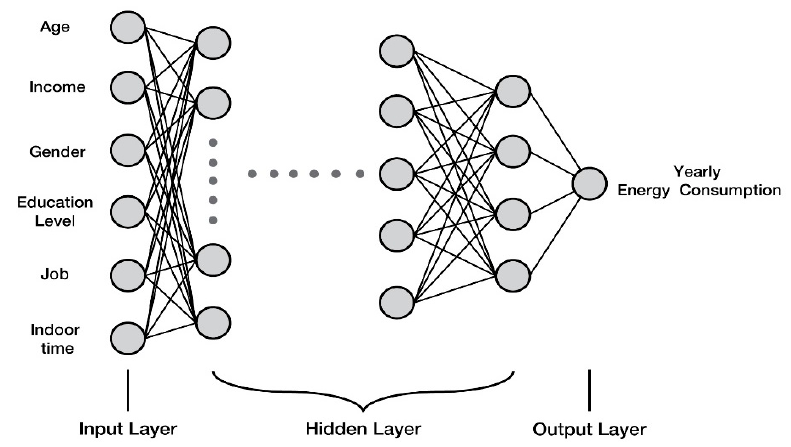
Figure 7. Model structure of the yearly energy prediction model